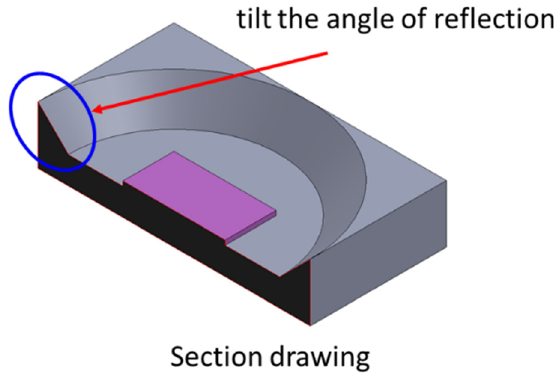
Figure 7. Three-dimensional illustration of the DUV-LED cavity showing the tilt angle of reflection.